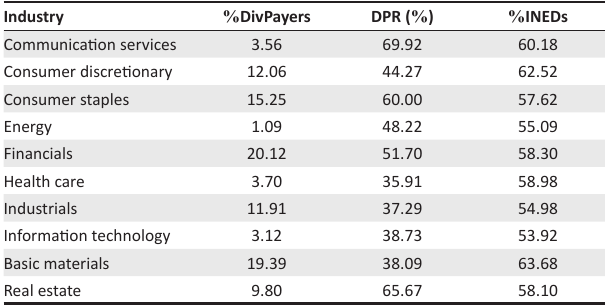
TABLE 5: Descriptive statistics per industry.